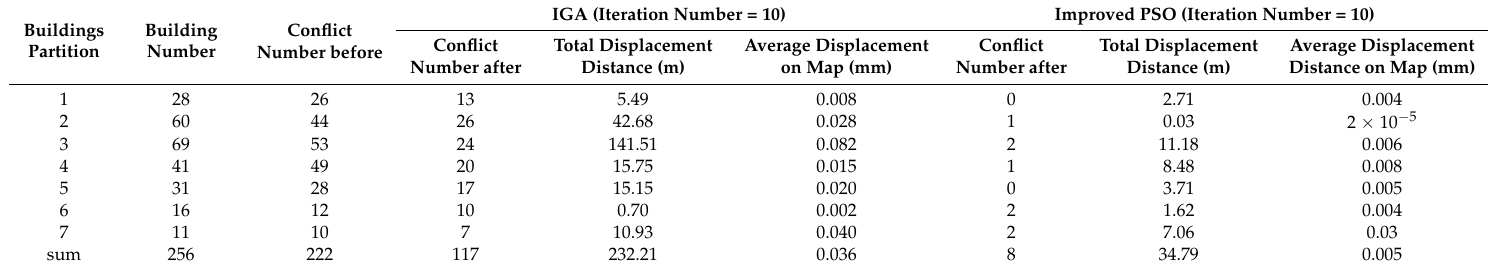
Table 1. Displacement results after 10 iterations.